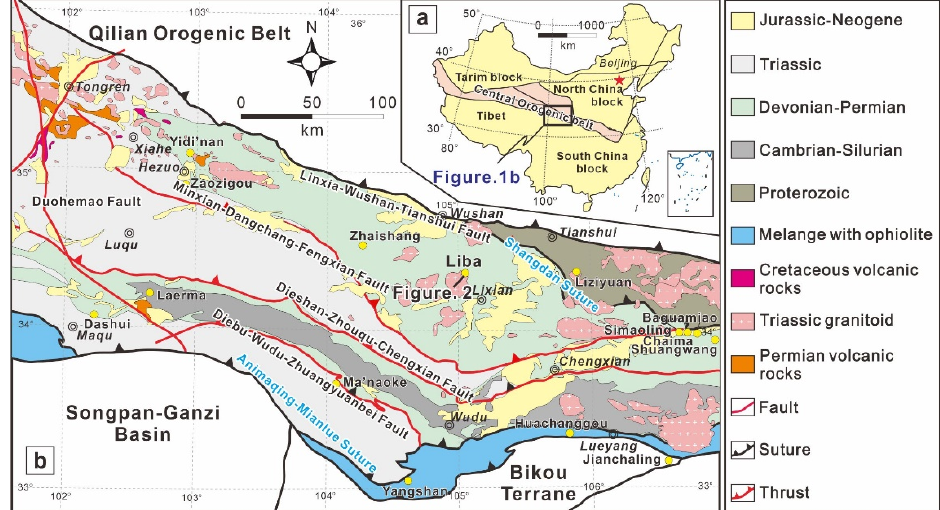
Figure 1. ( a ) Simplified map showing the location of the West Qinling Belt. ( b ) Geological map of the West Qinling Belt showing the major geological units (modified after [19]).